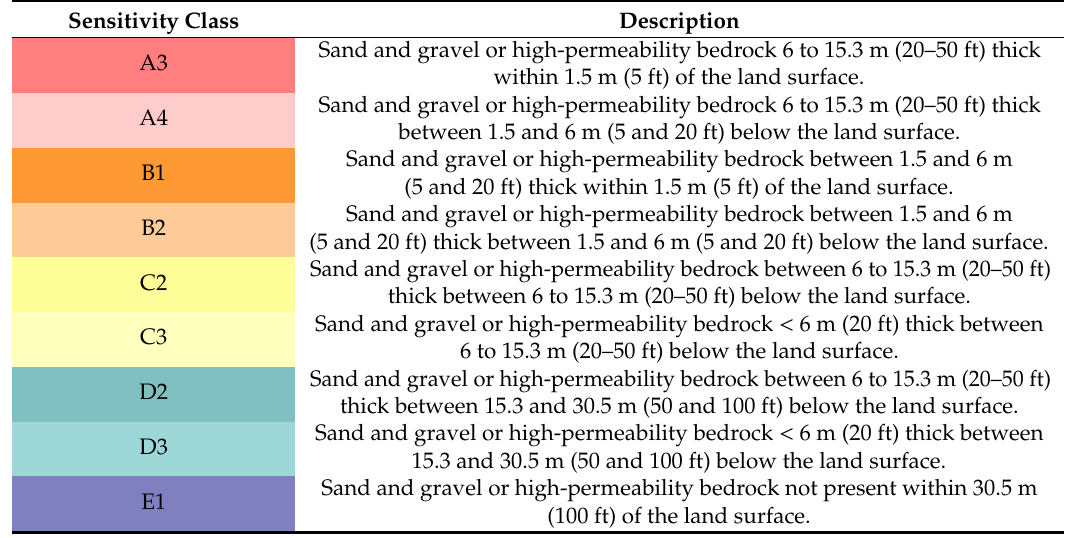
Table 2. Classification system for aquifer sensitivity (From [2]). Five primary map categories are di ff erentiated( A – E ).MaterialsdesignatedbyArepresenthighaquifersensitivity,